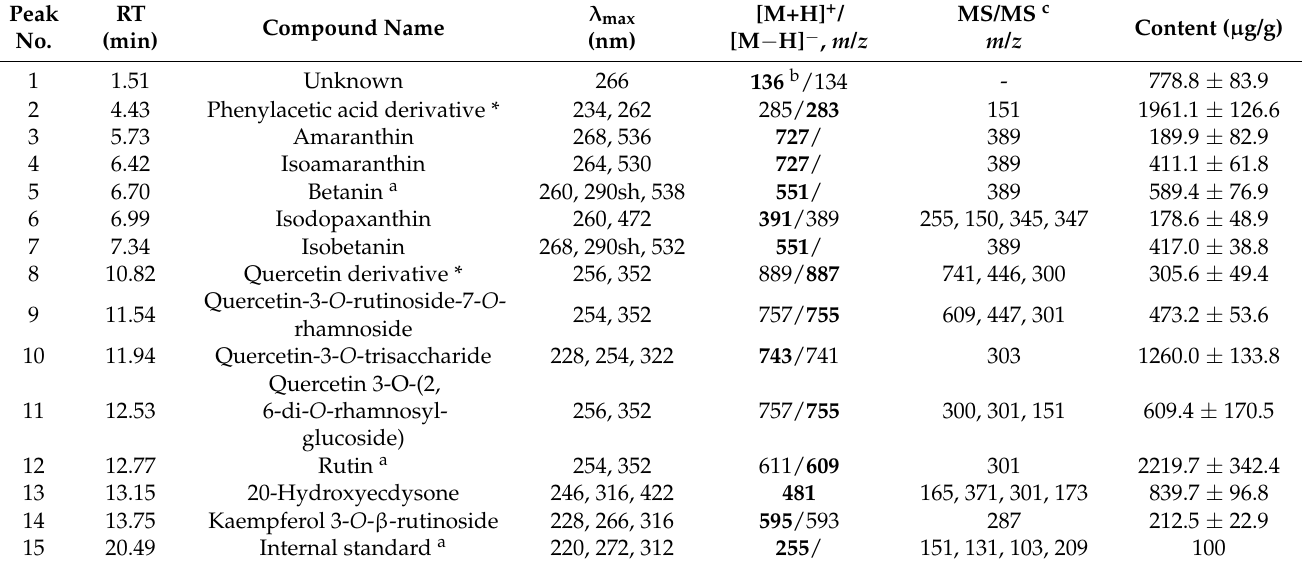
Table 1. HPLC-DAD-ESI-MS/MS analysis on the chromatographic and spectroscopic characteristics and content of water extract of djulis.